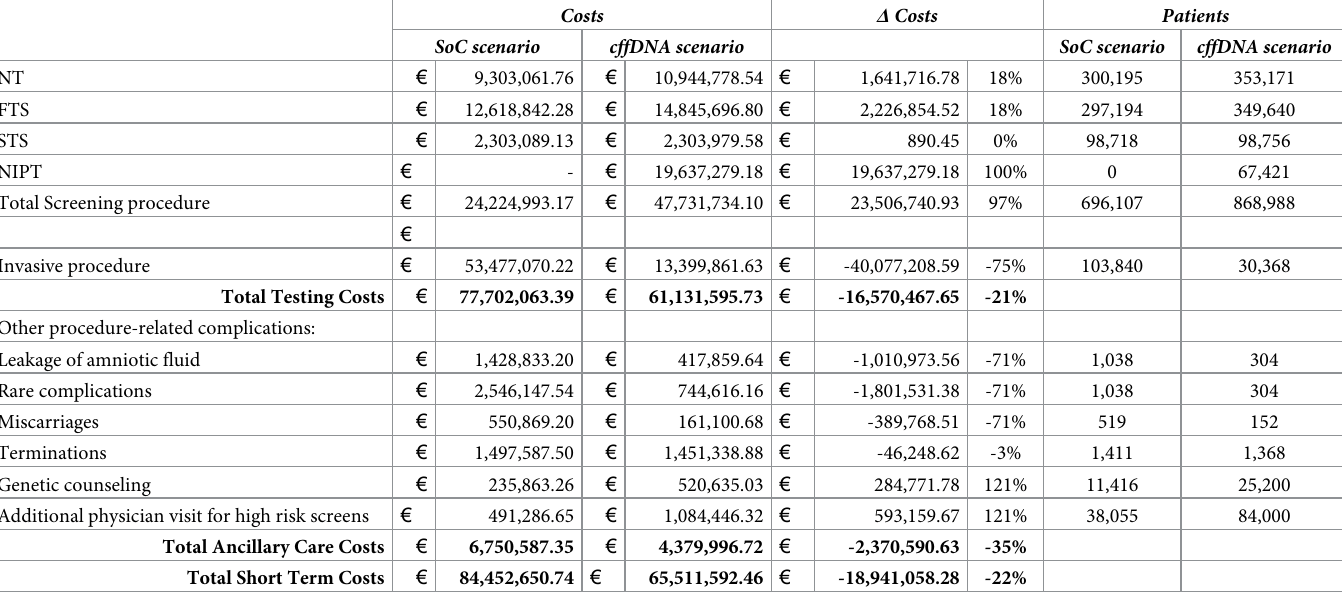
Table 4. Overall cost difference (SoC and cffDNA scenarios).